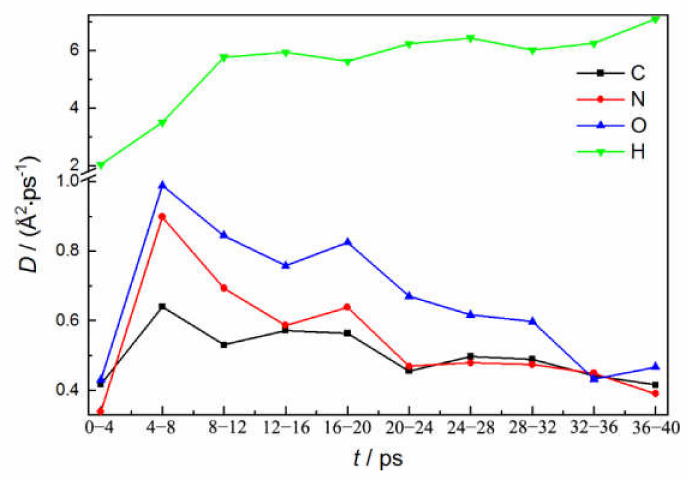
Figure 10. Diffusion coefficient of different atoms in HMX(100)HTPB shock